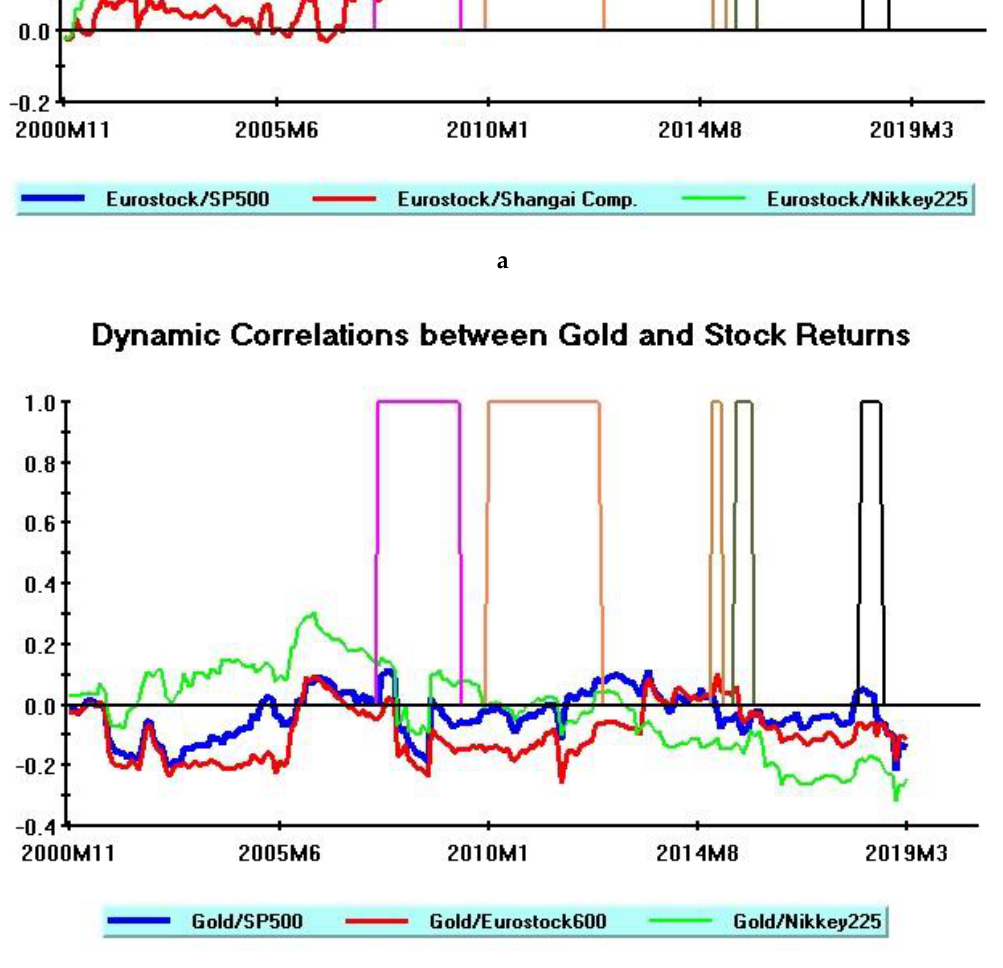
Figure 4. ( a ) Dynamic Correlations between Eurostock and Other Stock Returns; First vertical bars: Global financial crisis; Second vertical bars: Eurozone debt crisis; Third vertical bars: Russian financial crisis; Fourth vertical bars: Chinese stock market crisis; Fifth vertical bars: Turkish financial crisis. See also the discussion in Section 3.1. ( b ) Dynamic Correlations between Gold and Stock Returns. First vertical bars: Global financial crisis; Second vertical bars: Eurozone debt crisis; Third vertical bars: Russian financial crisis; Fourth vertical bars: Chinese stock market crisis; Fifth vertical bars: Turkish financial crisis. See also the discussion in Section 3.1.